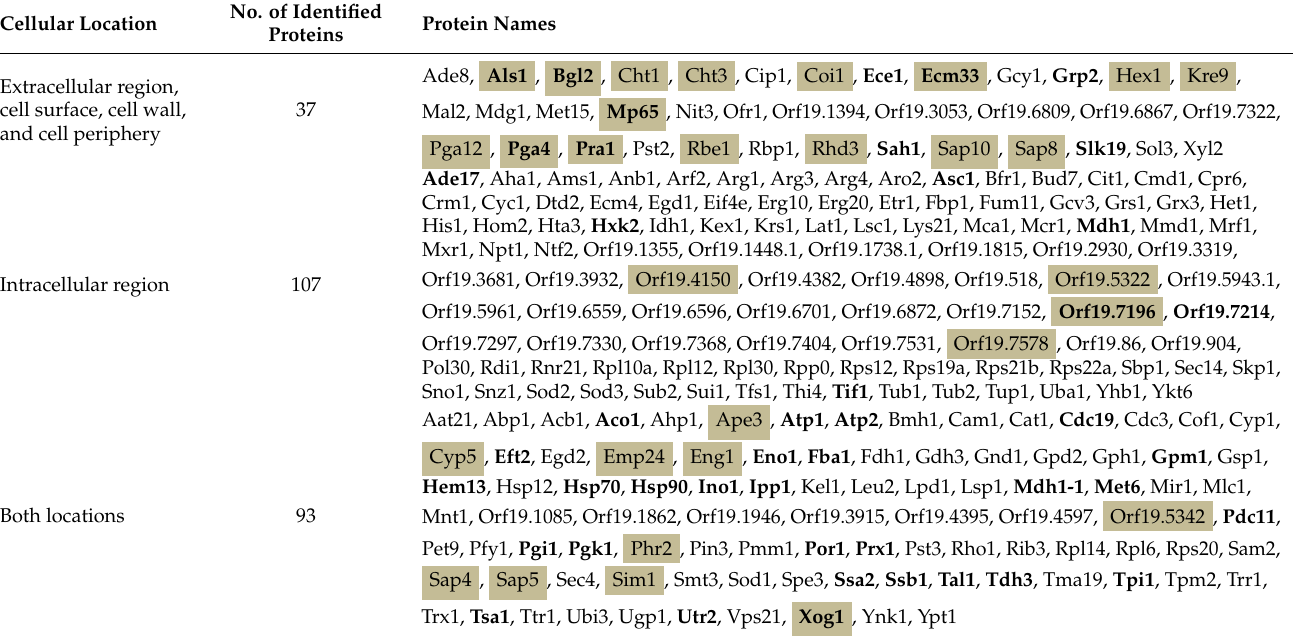
Table 1. List of the identified proteins in both secretome batches (S1 and S2) with at least two peptides classified regarding their cellular location a .